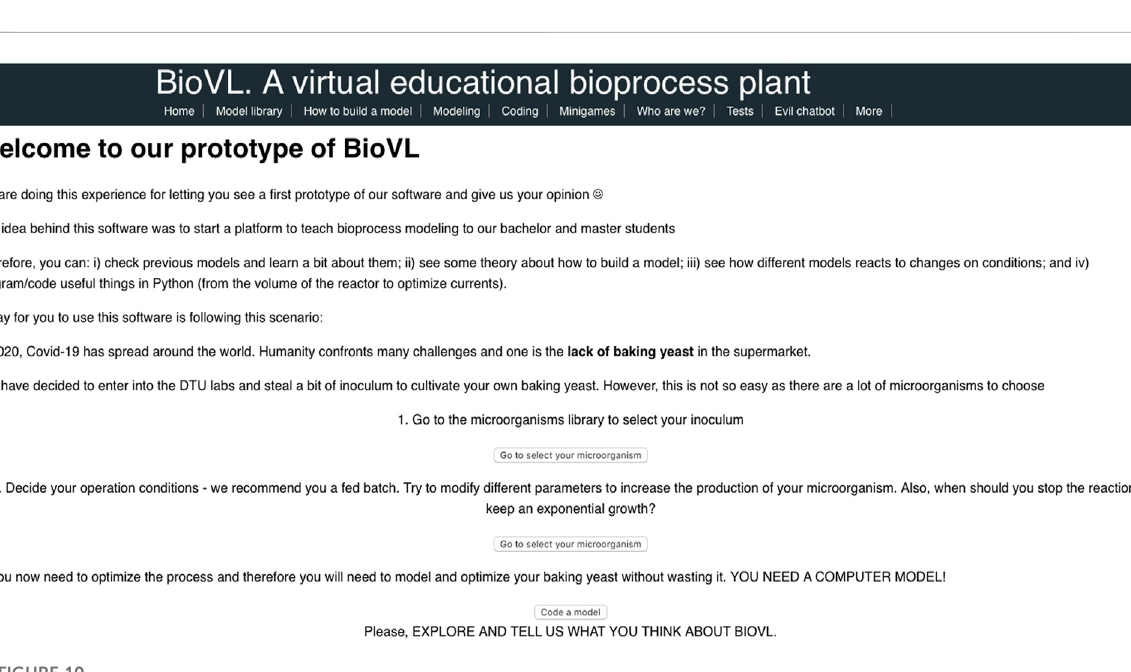
FIGURE 10 A semi-guided taskfor learning veri fi cation oftheBioVL prototype. Morescenarios will becontinuously added. Moreathttp://biovl.com/intro_